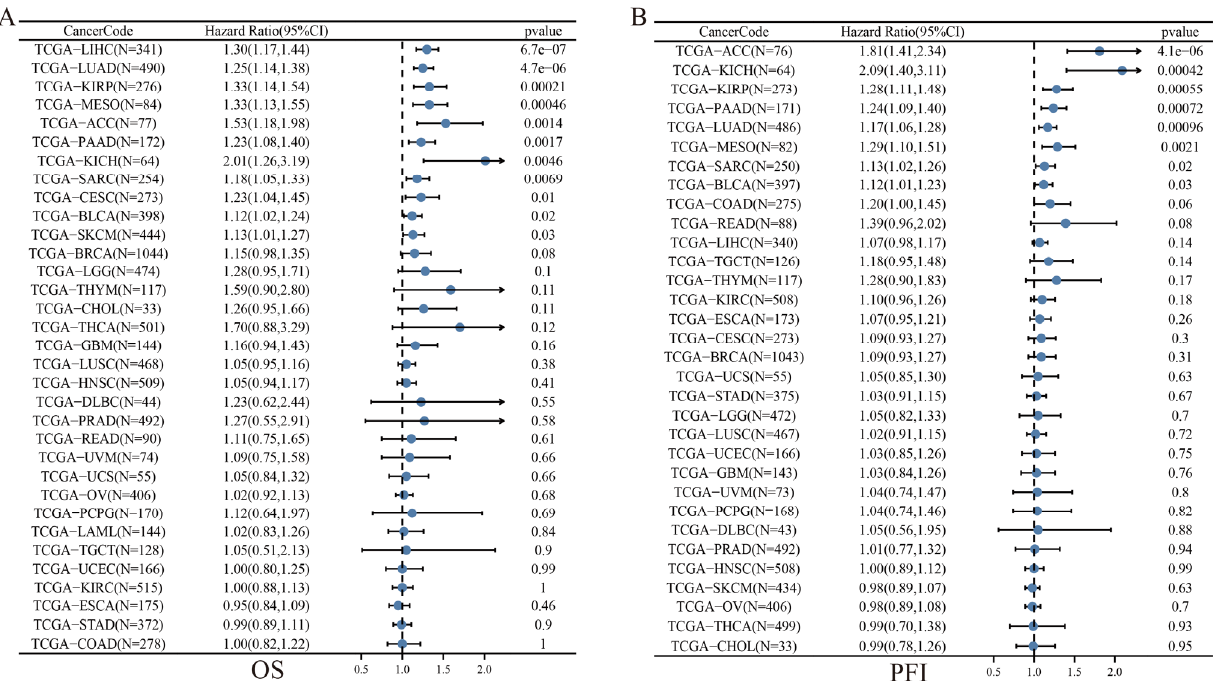
Figure 8. Univariate Cox regression analysis of SLC2A1. Forest map shows univariate Cox regression results of SLC2A1 for OS ( A ) and PFI ( B ) in pan-cancer.